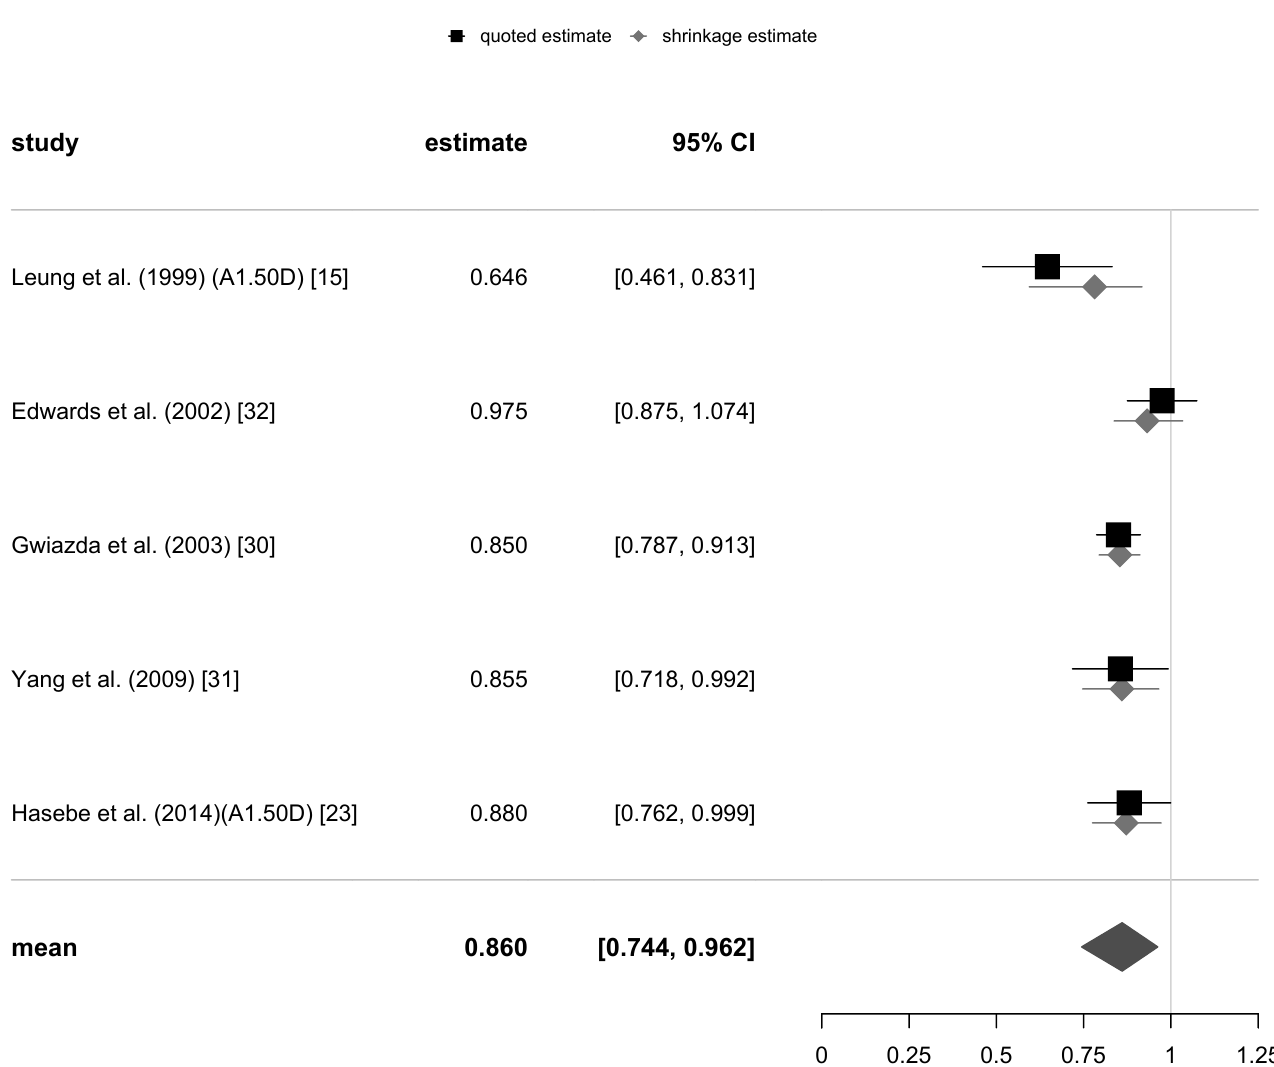
Figure 6. Forest plot for the scaled progression in axial length (AL) at the 24-months